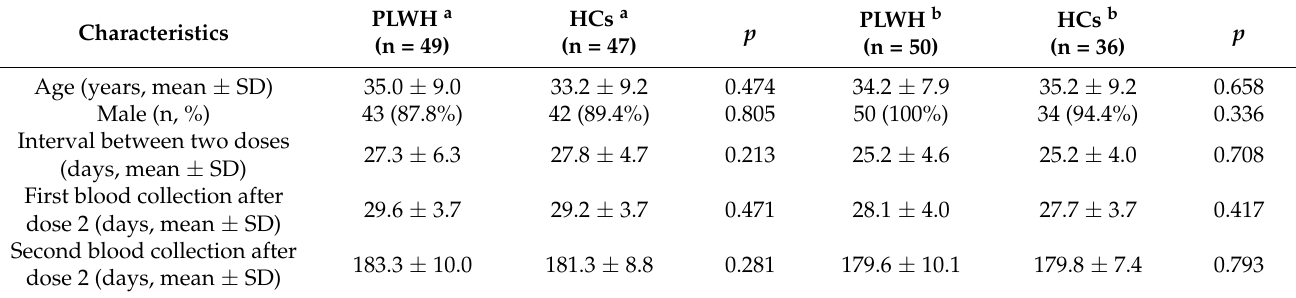
Table 4. Characteristics of PLWH and HCs who had completed second blood collection after two doses of BBIBP-CorV vaccine or CoronaVac vaccine (N =